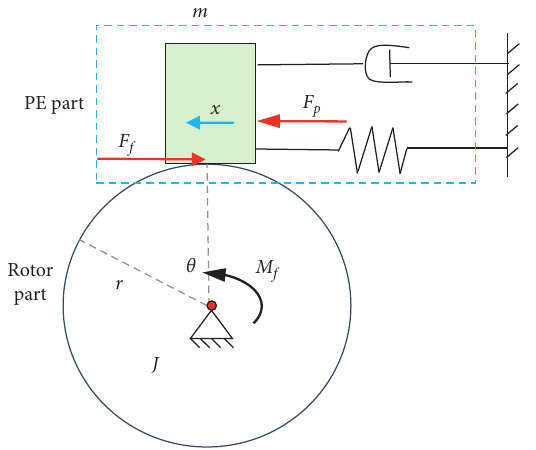
Figure 4: Dynamic model sketch.